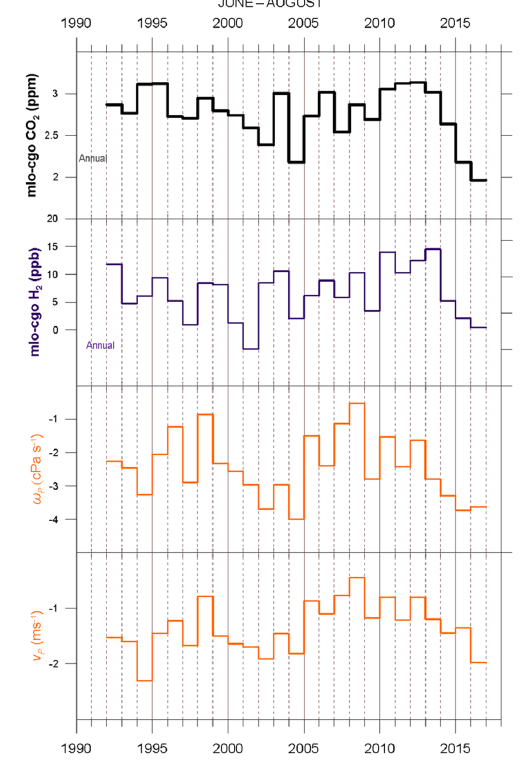
Figure 8. Time series of June–August and annual averages of de- trended mlo–cgo differences in CO 2 and H 2 and June–August av- erage dynamical indices ω P and v P